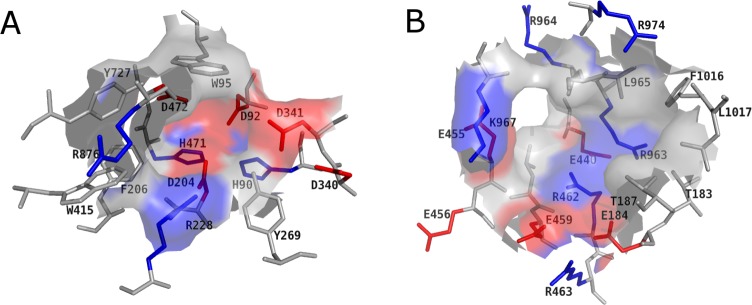
Colour-coded surface generated for the active site (A) and the identified pocket (B). Acidic and basic residues are coloured red and blue, respectively.